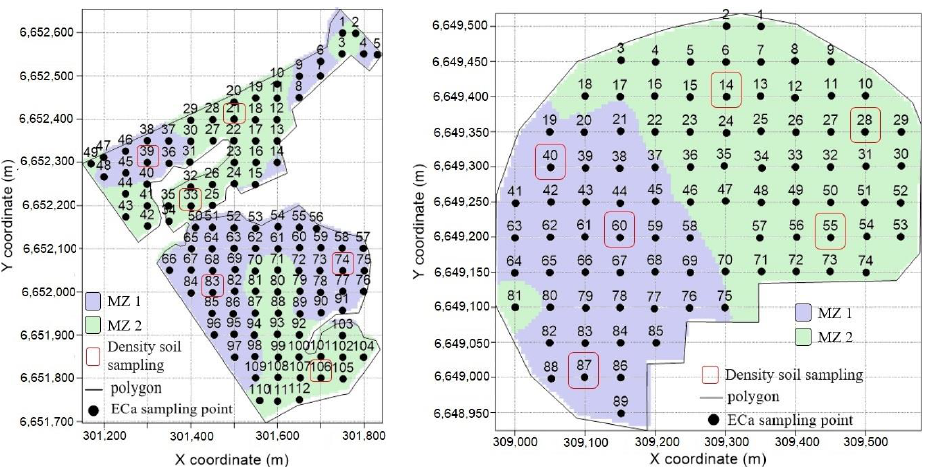
Figure 5. Maps of management zones delimited based on the spatial variability of the apparent soil electrical conductivity in fields A (rainfeed) and B (irrigated by central pivot). Cachoeira do Sul, RS.